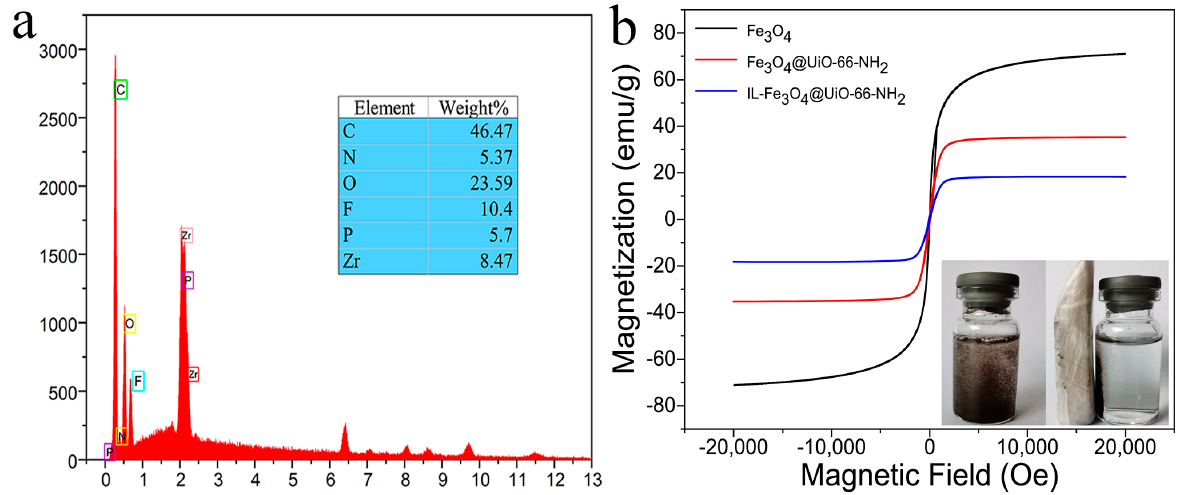
Figure 3. ( a ) EDS analysis of IL-Fe 3 O 4 @UiO-66-NH 2 ; ( b ) the hysteresis loops of the supports; the insert is a picture of the magnetic response.